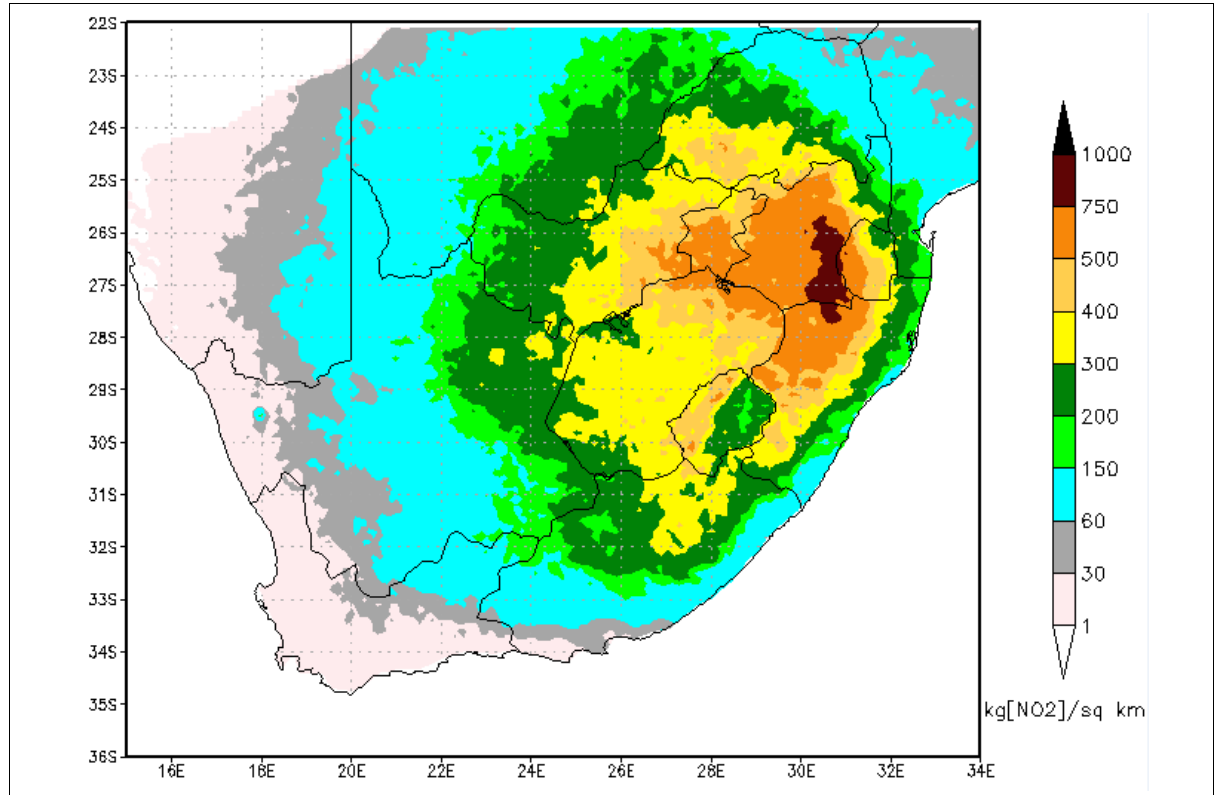
Figure 5: Average number of total LNO